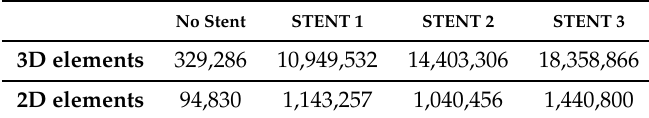
Table 3. Summary of the computational meshes used in this